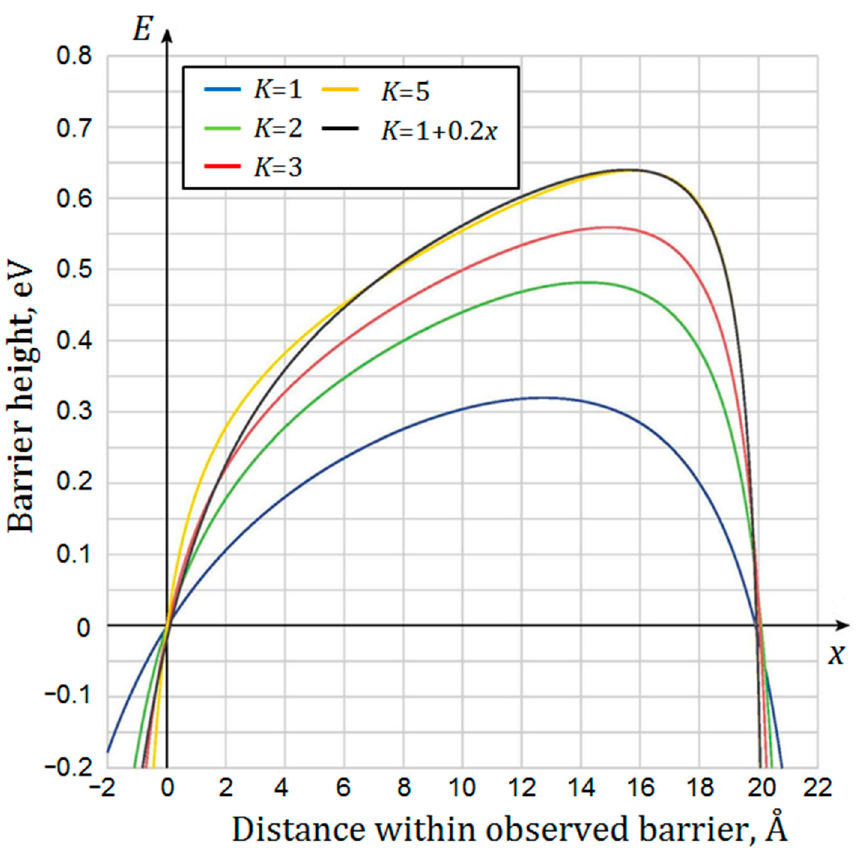
Figure 5. Barrier height ϕ i (x) in the MSM structure according to Formula (12) for ∆ ψ = 0.5 eV, ∆ s = 20 Å and various K values. Plots are shifted along the X axis to make the edges of observed barriers coincide for various K values.